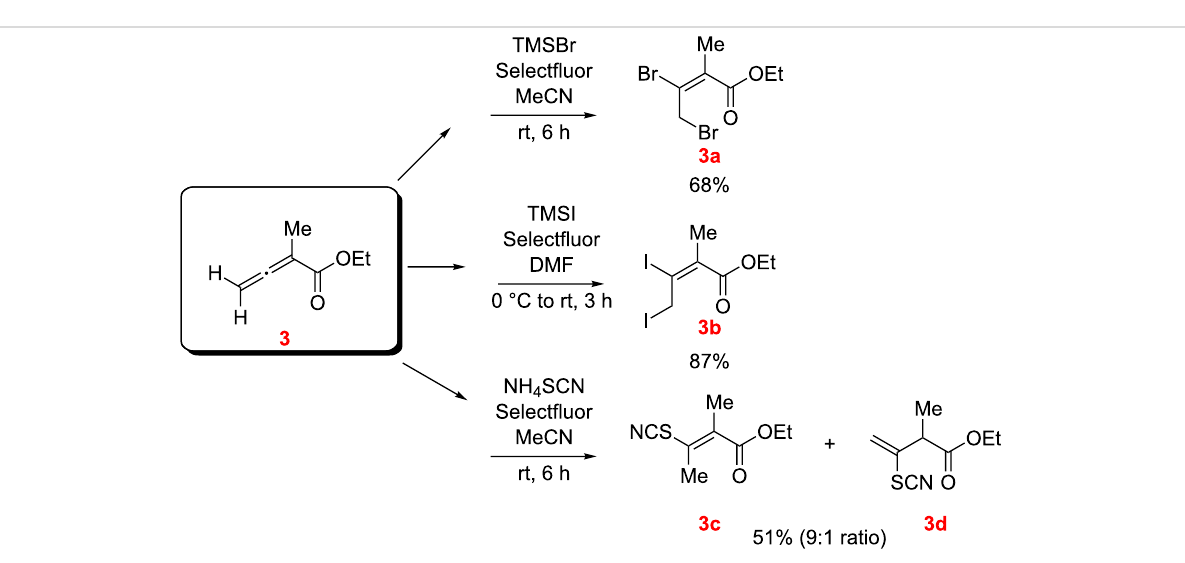
Scheme 6: Reaction of ethyl allenoate 3 with TMSX/Selectfluor and NH 4 SCN/Selectfluor ( E/Z designations, as illustrated, were made by NMR; see Supporting Information File 1).